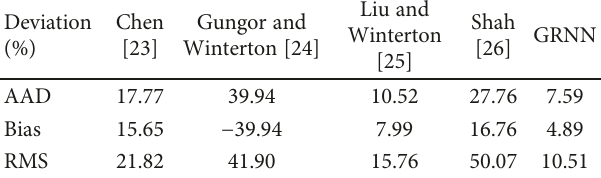
Table 6: Comparison of calculation error between the GRNN network prediction results and traditional relational calculation results.